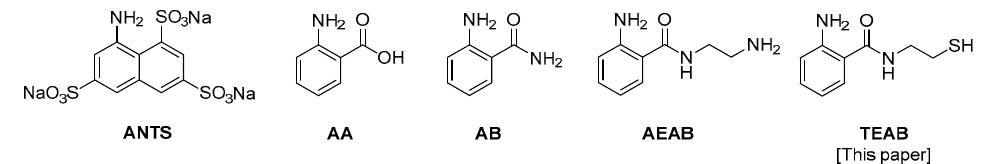
Figure 1. Iterations of glycan auxiliaries.